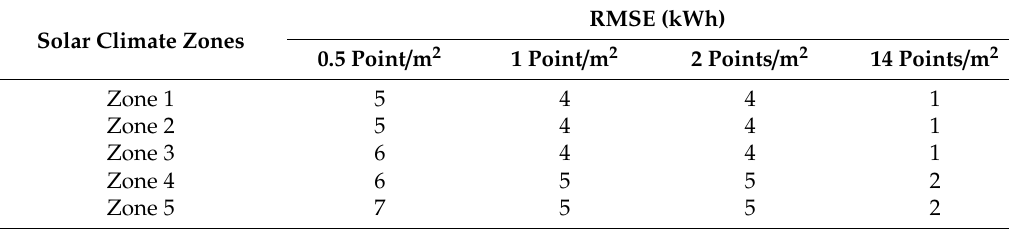
Table 18. Average daily PV energy production loss (kWh) due to the error in the estimation of the rooftop area for di ff erent point cloud densities: residential building with a hipped roof of 100 m 2 .